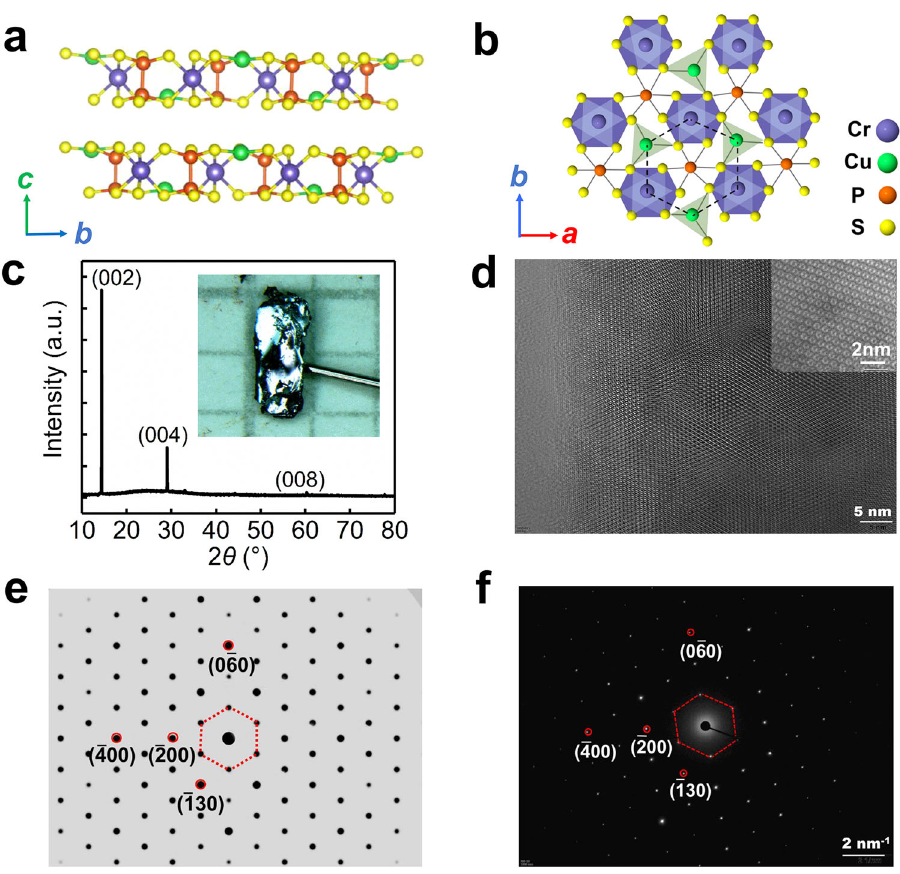
Fig. 1 | Characterizations of vdW multiferroic CCPS single crystal. a The side- view (interlayer bc -plane) and b the top-view (intralayer ab -plane) of CCPS atomic structure,Cu,Cr,P,andSionsarerepresentedbygreen,blue,red,andyellowballs, respectively. c TheXRDscanindicating(002),(004),and(008)peakre fl ectionsfor the ab -planeofas-grownCCPSsinglecrystal.Theinsetshowsaphotoofthecrystal